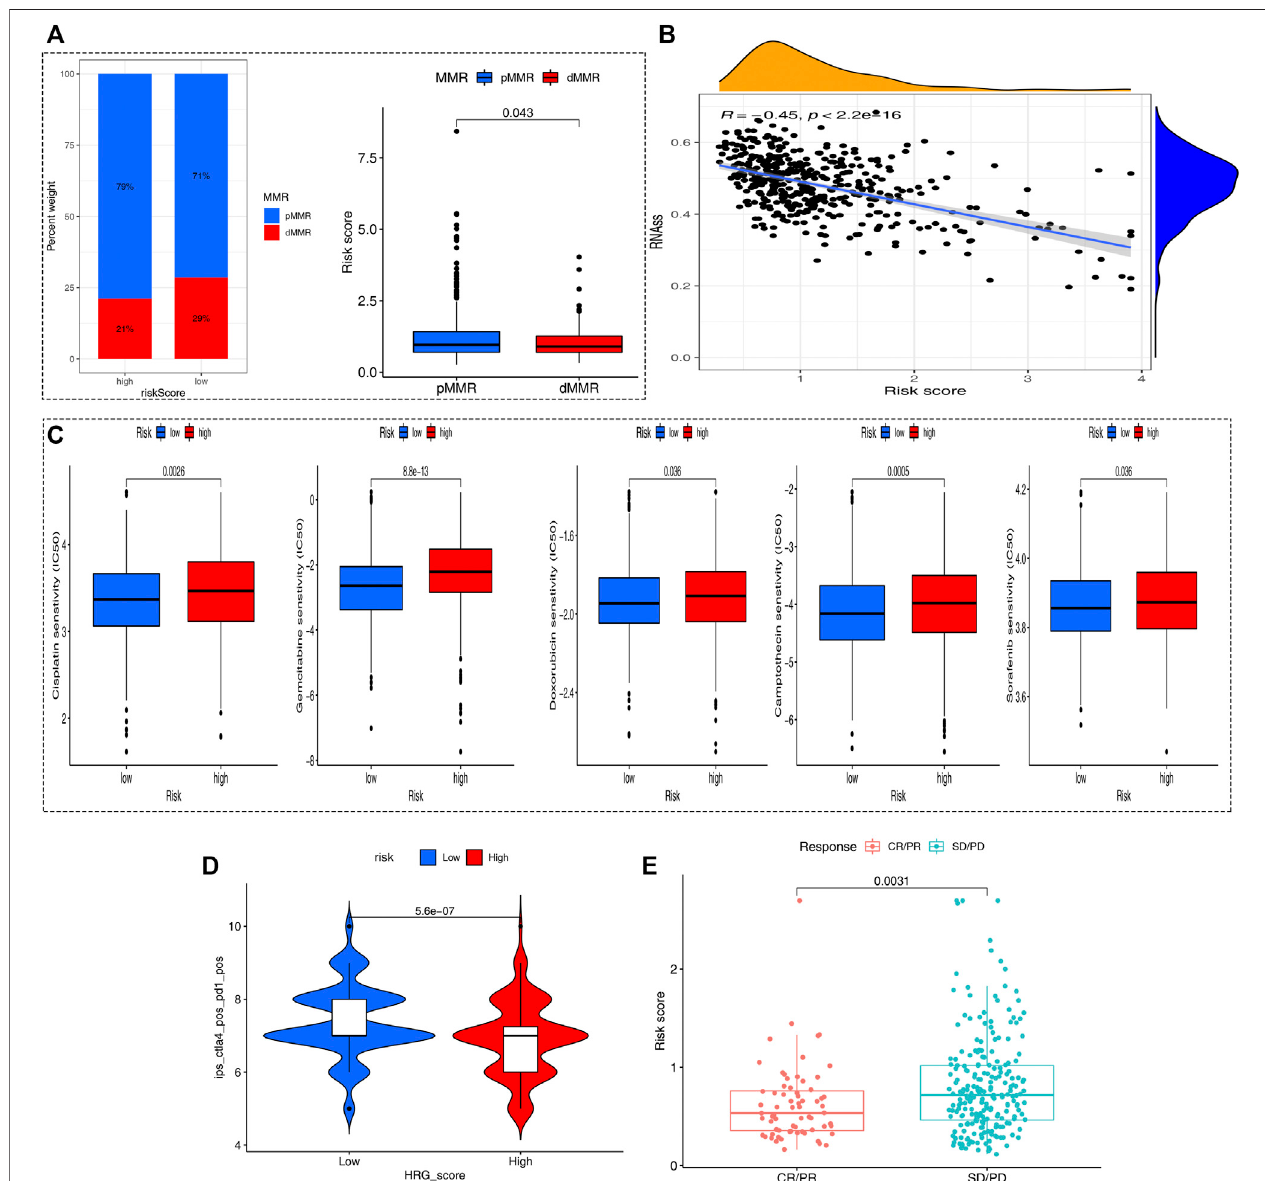
FIGURE7| ComprehensiveanalysisoftheHRG-scoreinCOAD. (A) RelationshipsbetweentheHRG-scoreandMMRstatus. (B) RelationshipsbetweentheHRG- score and CSC index. (C) Relationships between HRG-score and sensitivity of fi ve chemotherapeutics. (D) Prediction of the response of different risk samples to the combination of anti-CTLA4 and anti-PD1 based on IPS. (E) Boxplot for assessing HRG-score in predicting anti-PD-L1 response through the IMvigor210 cohort.